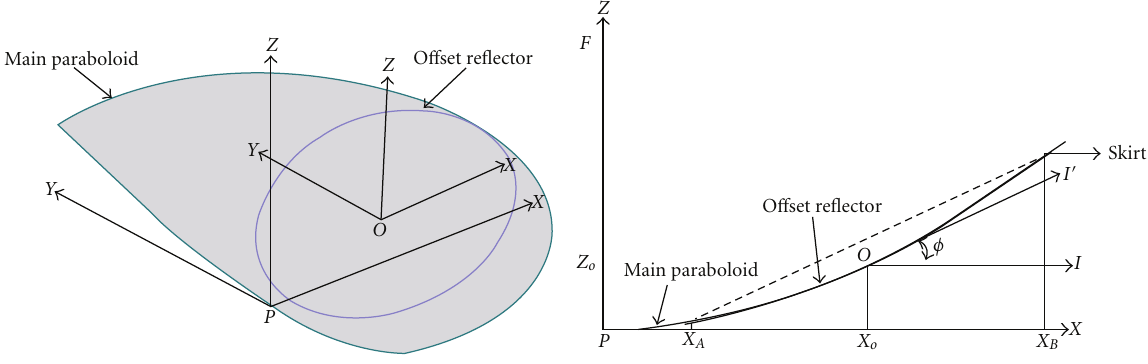
Figure 1: O ff set reflector.